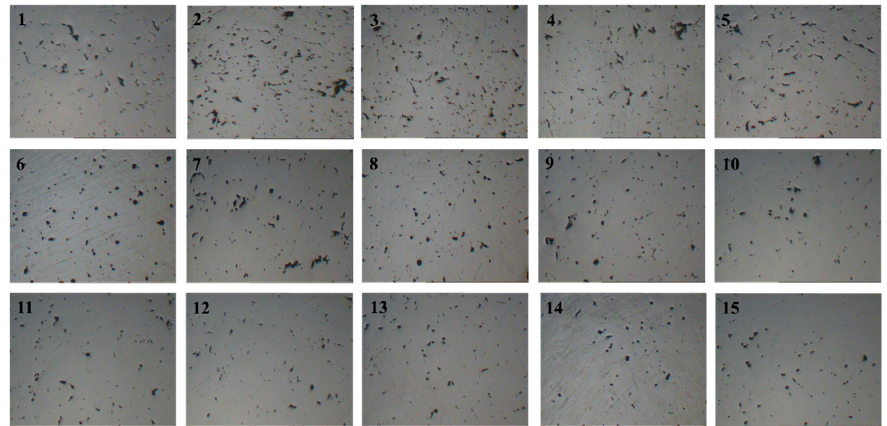
Figure 4. OM images of PM TC4 alloy when sintered at ( a ) 1300 °C, 120 min, 5 °C/min; ( b ) 1300 °C, 240 min, 5 °C/min.